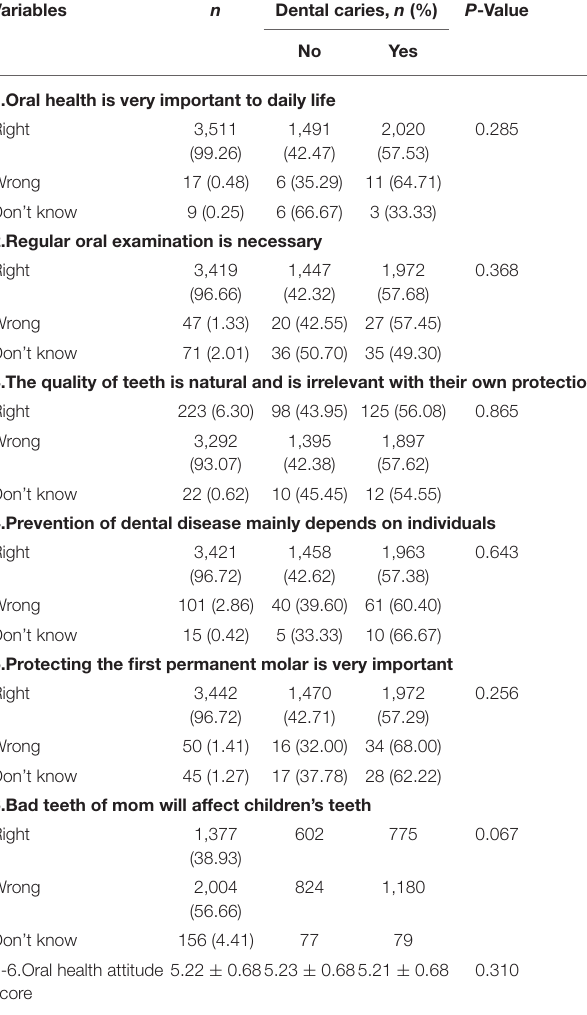
TABLE 4 | Response distribution on parents’ attitude toward oral health regarding ECC. Variables